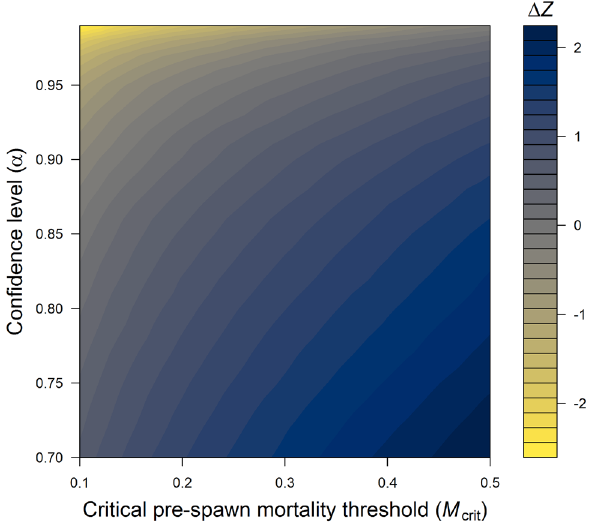
Figure 7. Estimates of restoration effort or preservation resilience (Δ Z ) vary with uncertainty, i.e., the critical level of pre-spawn mortality ( M crit ) and the desired uncertainty level ( α ), as shown here for one example subbasin (#845). The change in urbanization relative to current conditions (Δ Z ) needed to ensure a predicted mortality risk no greater than M crit with probability α is shown for an arbitrary site. In this example, the site may fall into either the restoration (Δ Z < 0) or preservation (Δ Z > 0) category depending on the criteria specified. More stringent criteria (lower M